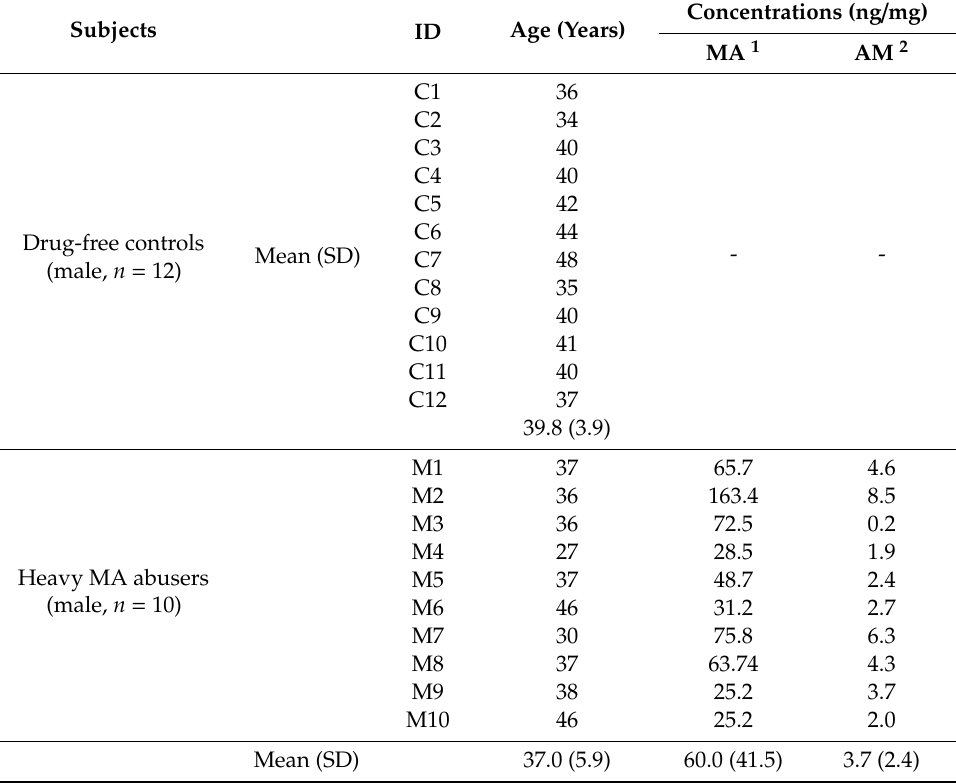
Table 1. Study subjects and hair concentrations of methamphetamine (MA) and amphetamine (AM).